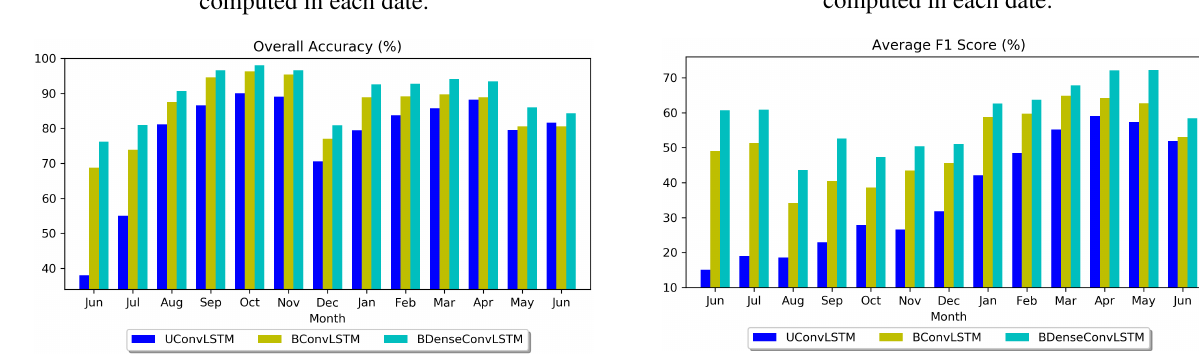
Figure 8. Overall Accuracy for LEM study area, computed in each date.